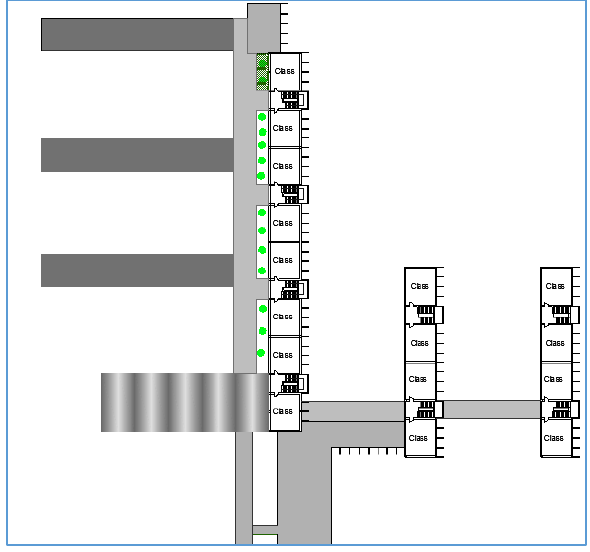
Figure 8. The First and Second Floor Plan for Lefkoşa türk lisesi (Drawn by